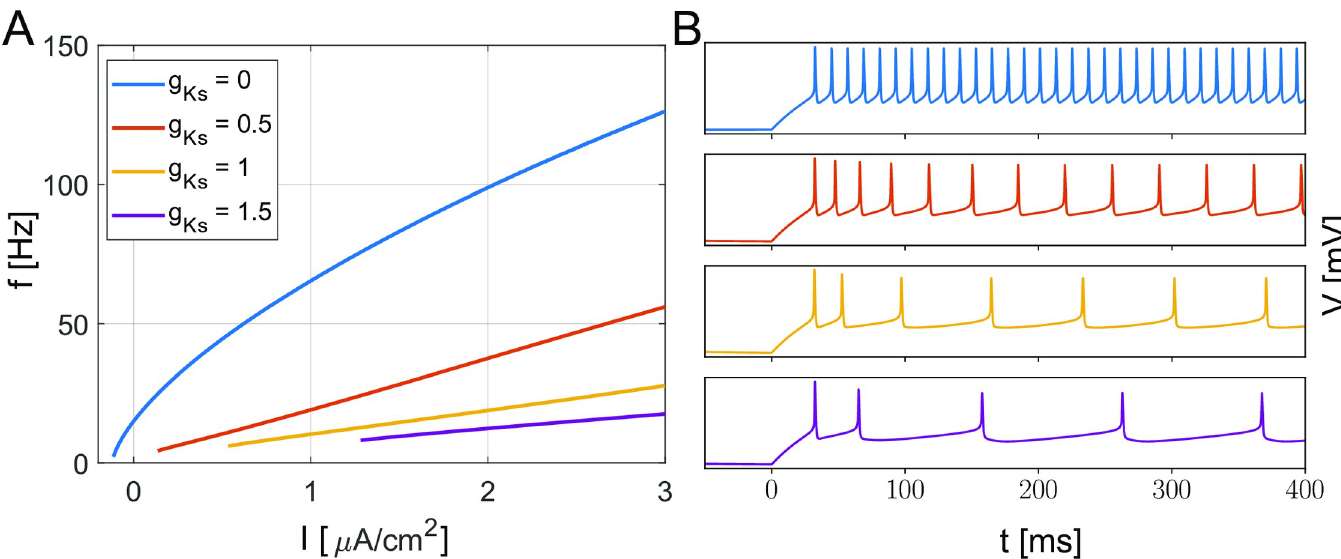
Fig 8. Cholinergic modulation of neuron frequency-current relationship. A , Frequency-current (f-I) curve of the cortical neuron model with different g simulating different levels of ACh neuromodulation ( g Ks = 0 mS/cm 2 for high ACh modulation and g Ks = 1.5 mS/cm 2 for no ACh neuromodulation). B , Spike-Frequency- values with current of 1.5 μ A/cm 2 being applied (Same color code with A Adaptation (SFA) showed by the voltage traces of different g Ks